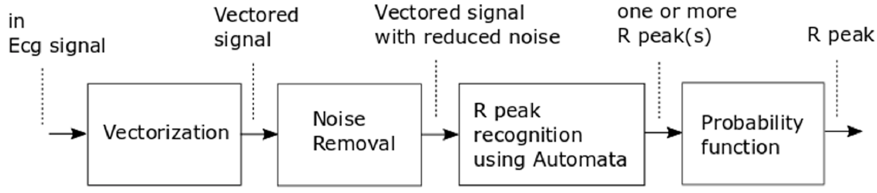
Figure 2. Block diagram of ECG signal processing.